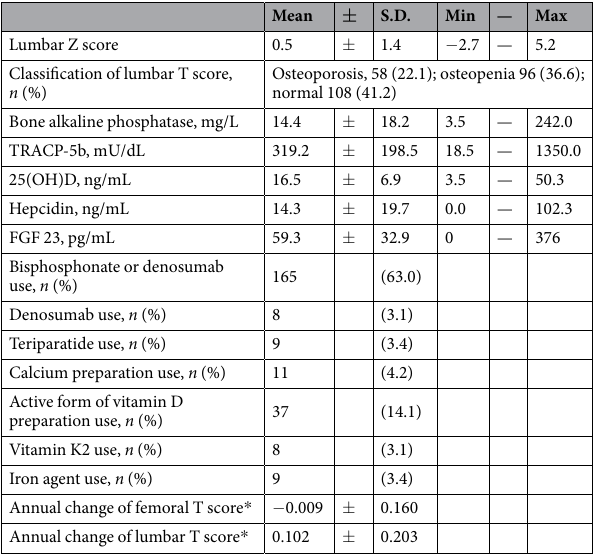
Table 1. Characteristics of the study subjects. DAS28, disease activity scores in 28 joints; ESR, erythrocyte sedimentation rate; CRP, C-reactive protein; SDAI, simplified disease activity index; CDAI, clinical disease activity index; HAQ-DI, health assessment questionnaire without disability index; DMARDs, disease- modifying antirheumatic drugs; eGFR, estimated glomerular filtration rate; UIBC, unsaturated iron binding capacity; TRACP-5b, tartrate-resistant acid phosphatase-5b; 25(OH)D, 25-hydroxy vitamin D; FGF23, fibroblast growth factor 23. * Annual change of T score was evaluated in 231 patients and the mean observational period was 2.0 ± 0.33 years